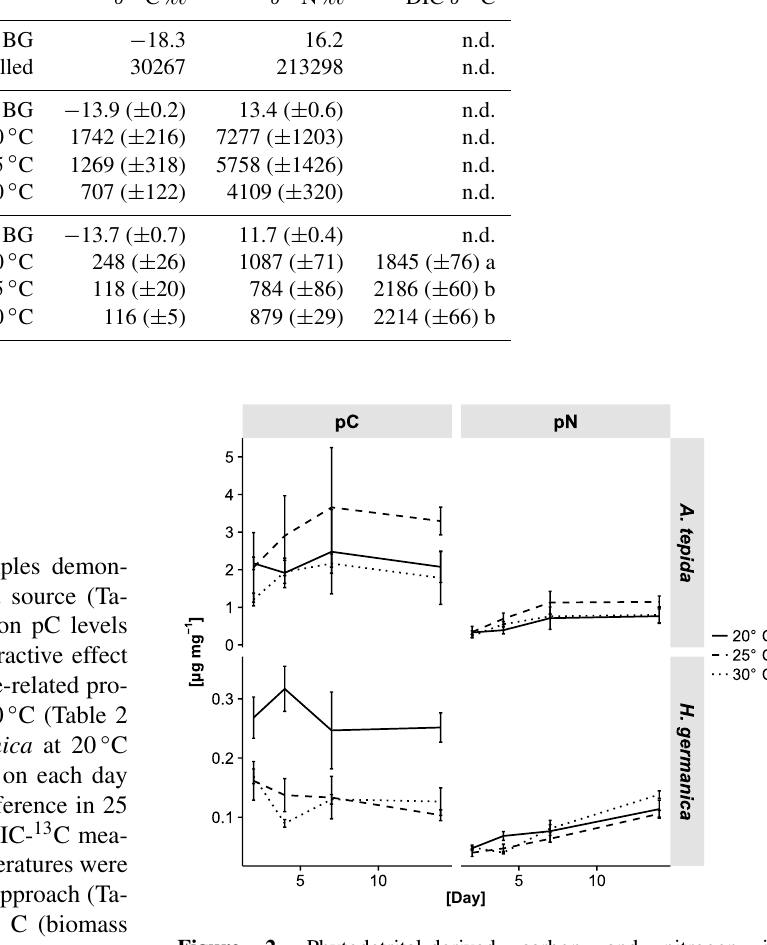
Figure 2. Phytodetrital-derived carbon and nitrogen in foraminiferal cytoplasm. Biomass normalised pC and pN of A. tepida and H. germanica at 20, 25 and 30 ◦ C. Error bars denote standard